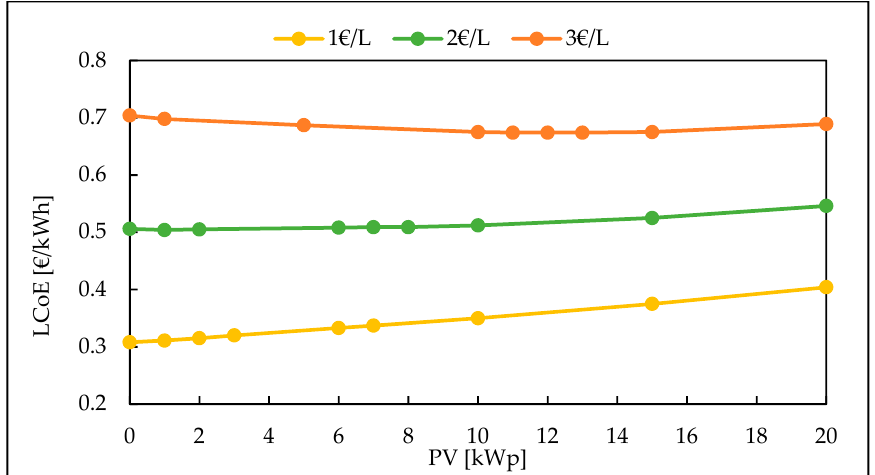
Figure 9. PVGenSet system depending on PV and diesel price.